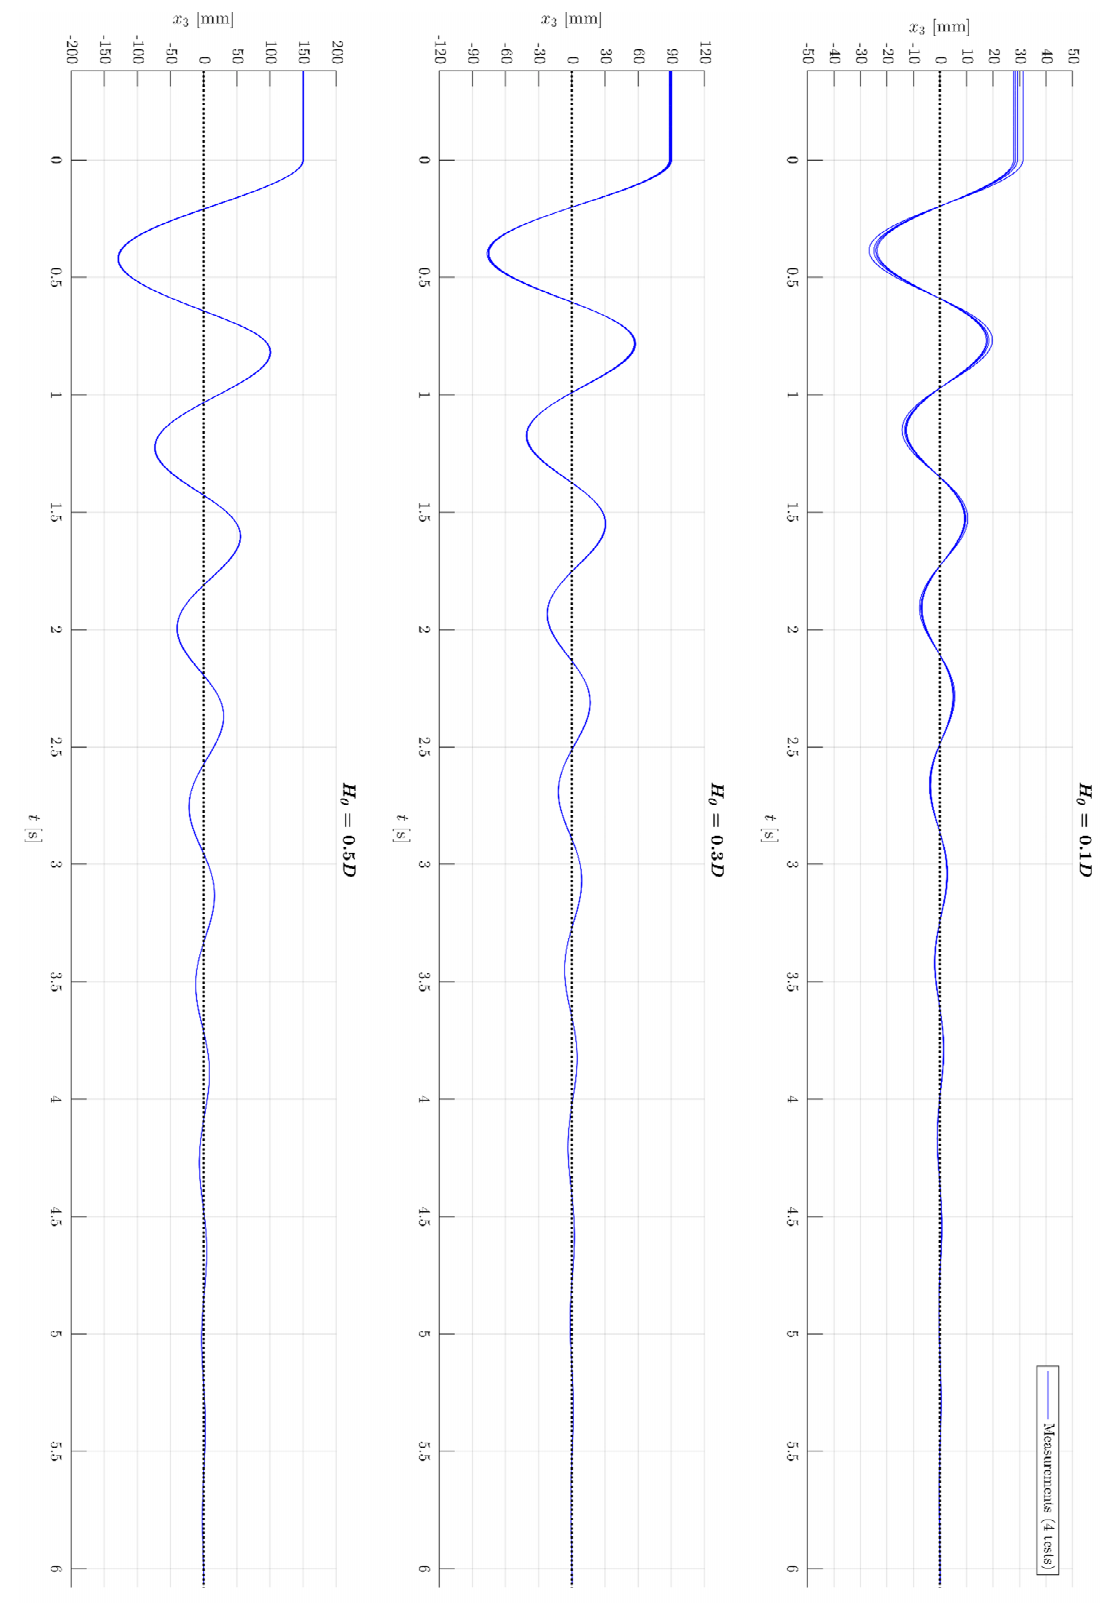
Figure A8. Raw decay time series for the three investigated drop heights.